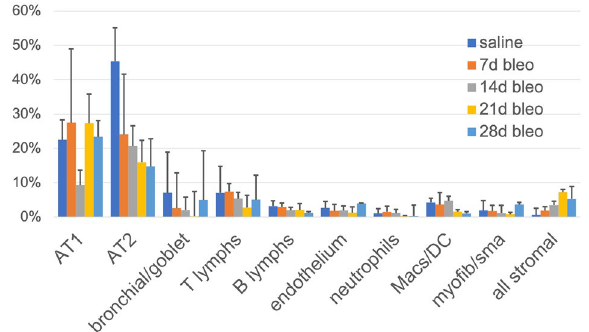
Figure 3. Classification and frequency of cell types in controls and treated mice. The cell types identified in the lungs are shown as mean ± SD for individual mice for each treatment. AT2 represents AT2 and transitional AT1/ AT2 alveolar cells (see supplementary data); bronchial/goblet = bronchial cells and MUC5B cells merged; all stromal = phenoclusters with mesenchymal markers merged. For details see supplementary Table 1.